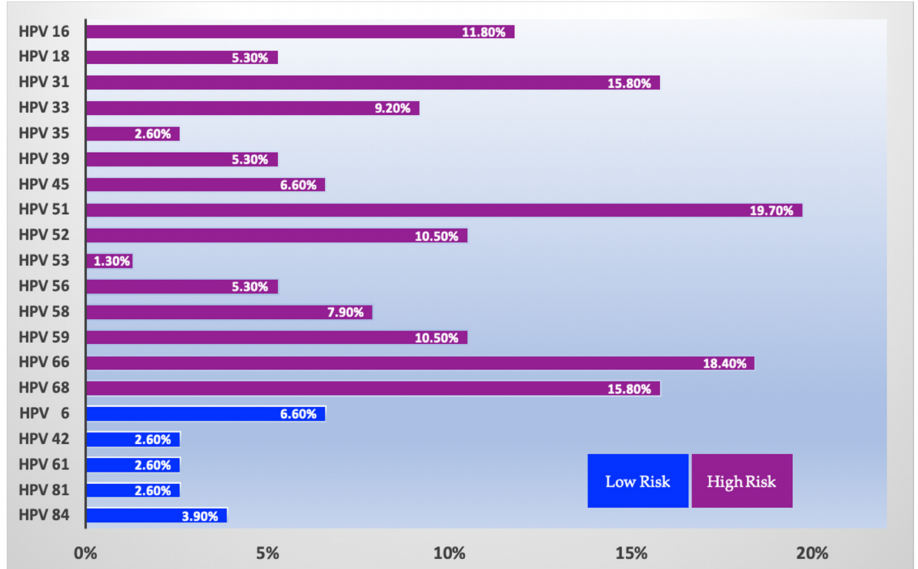
Figure 1. Distribution of HPV subtypes in HPV DNA positive women of the study